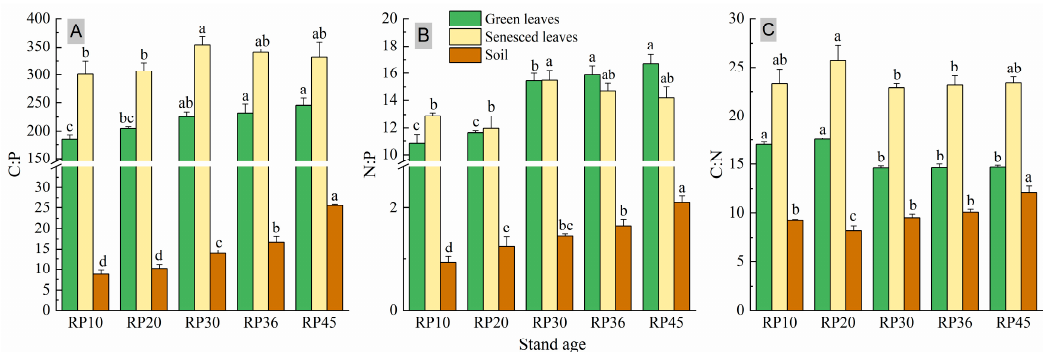
Figure 1. Leaf and soil C:P ratio ( A ), N:P ratio ( B ) and C:N ratio ( C ) in black locust forests with different stand ages. Different lowercase letters represent significant differences among stand ages at p < 0.05, and the same letters indicate no significance.